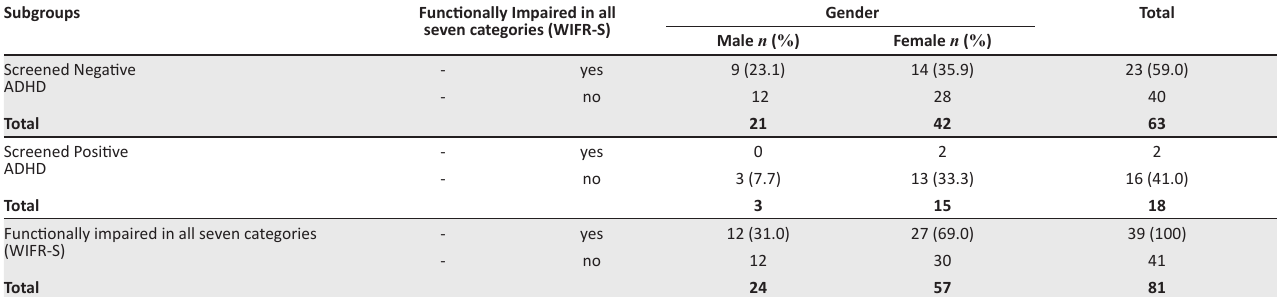
TABLE 3: Descriptive findings for parents within the ADHD subgroups and in all seven categories of the WFIR-S ( n = 39). Subgroups Functionally Impaired in all seven categories (WIFR-S)